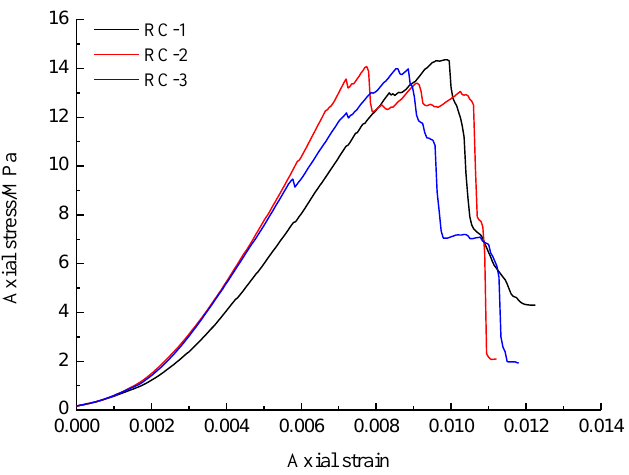
Figure 4. Uniaxial stress-strain curves of sandstone-coal composite samples.